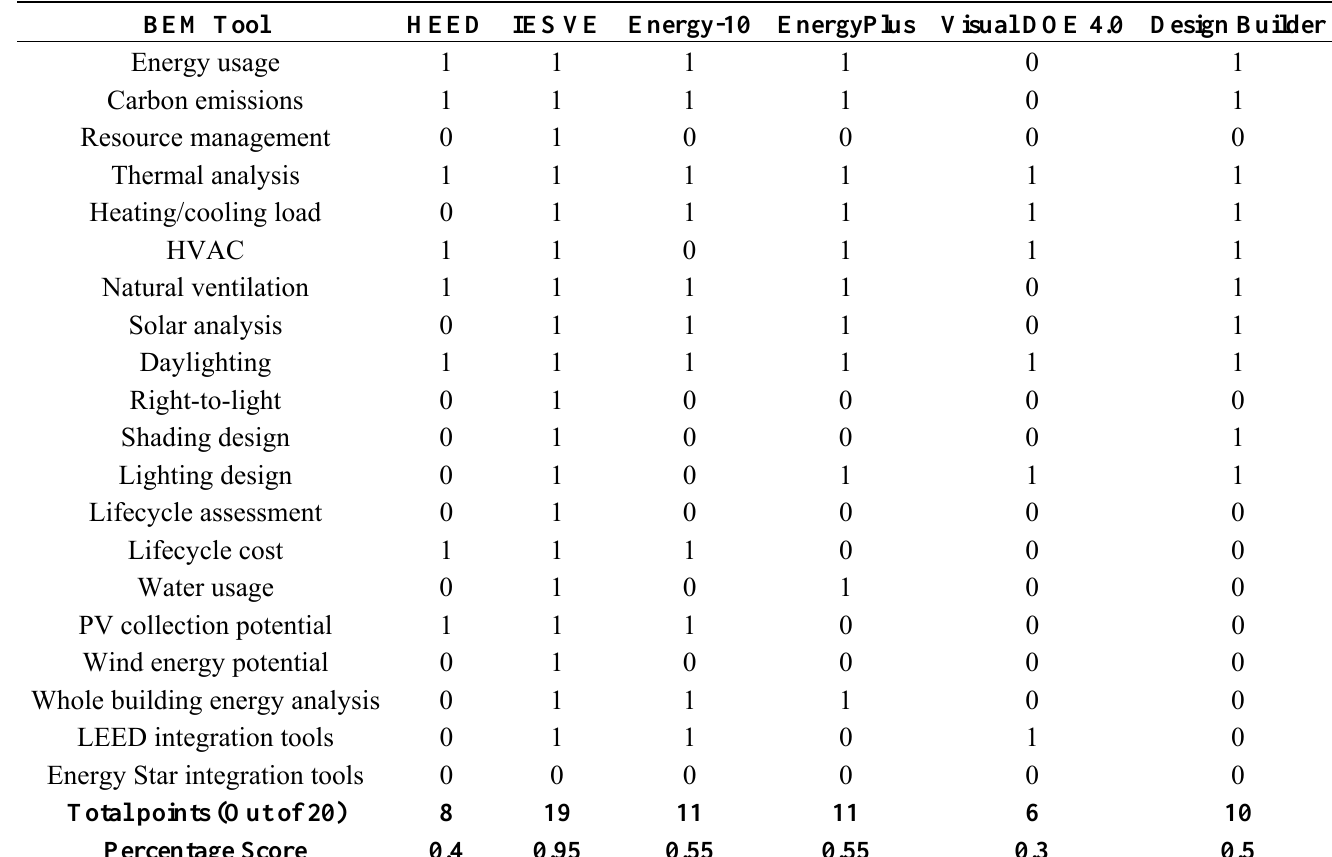
Table A5. Initial evaluation: available outputs criterion calculations for BEM tools (Part